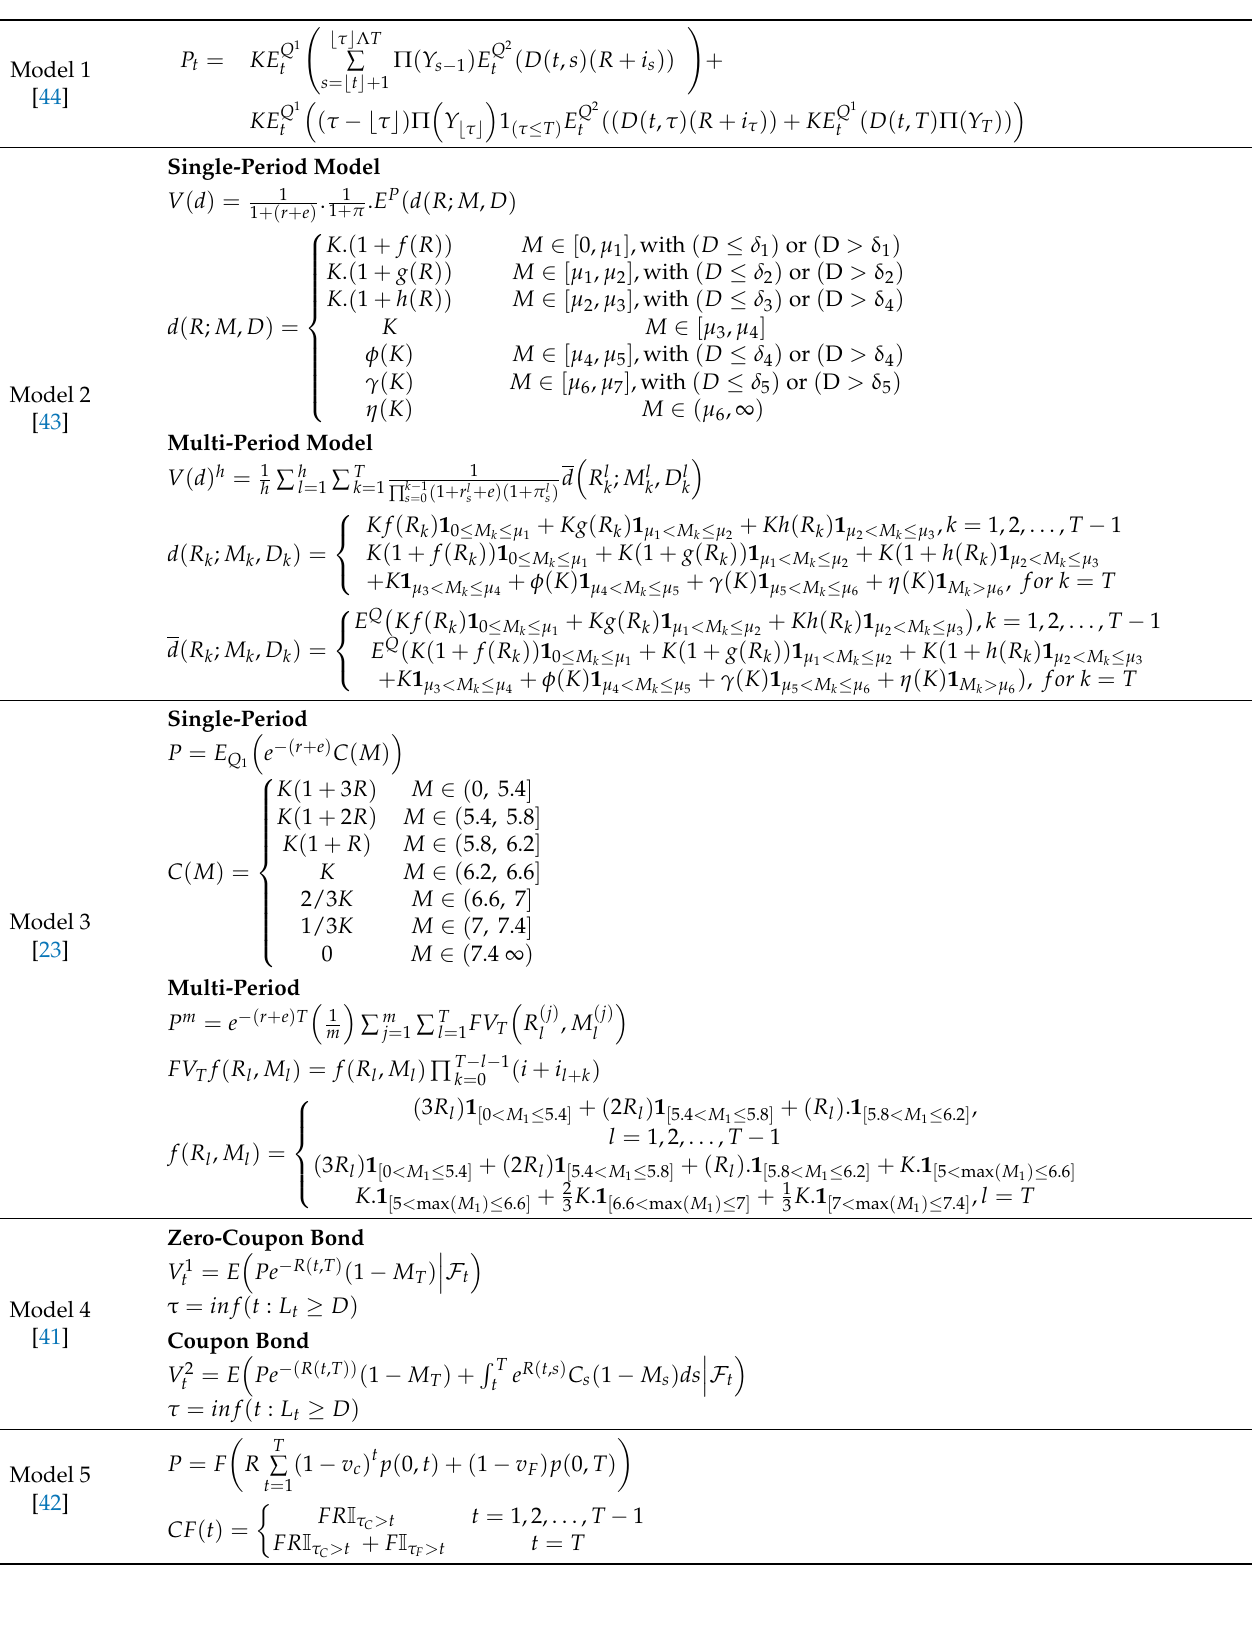
Table 5. Previous earthquake catastrophe bond pricing